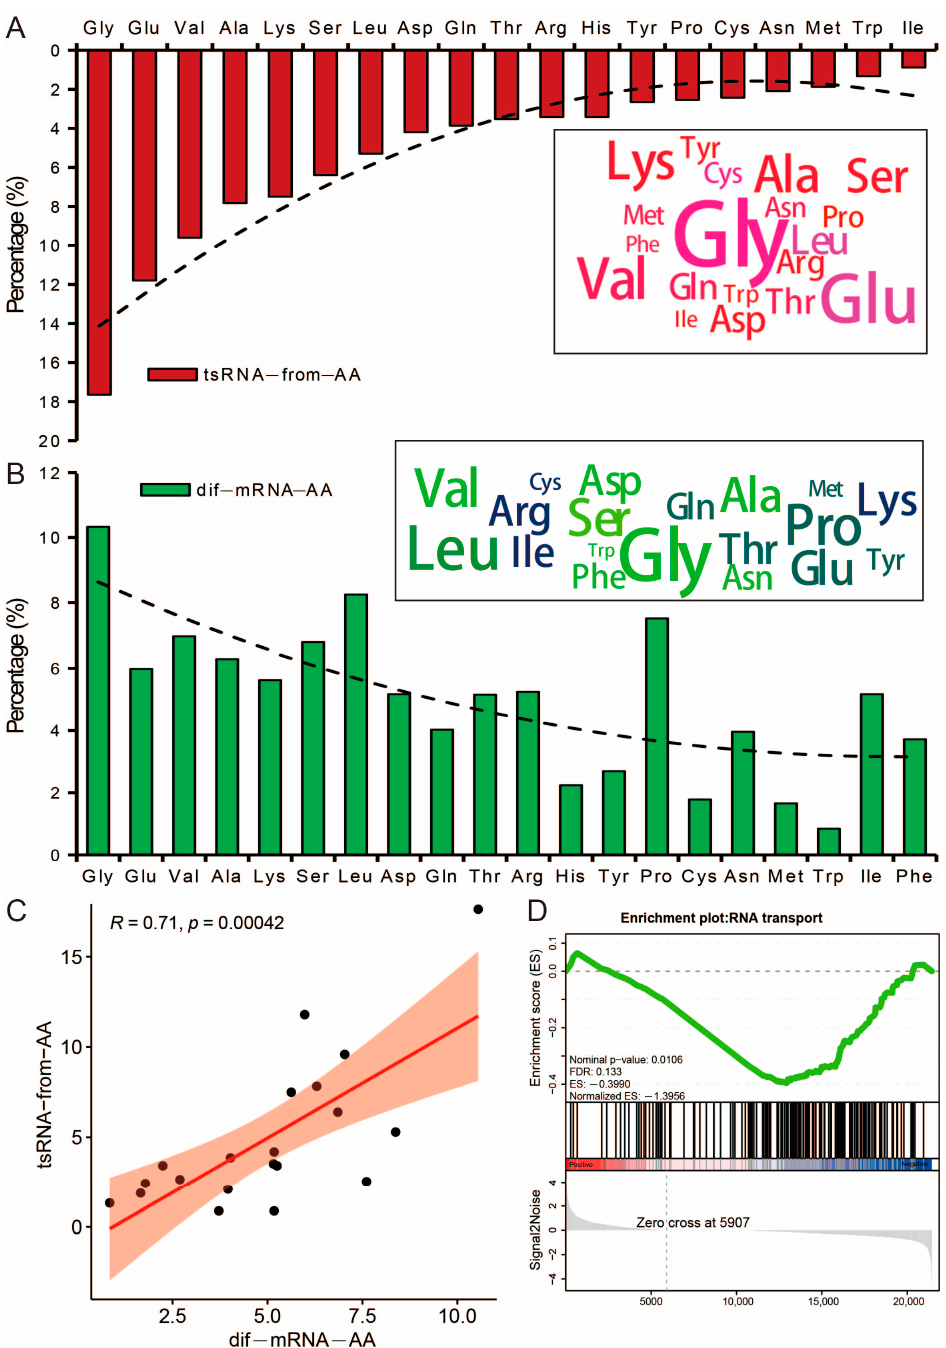
Figure 6. Potential relationship between tsRNA production and host tRNA. ( A ) The portion of tsRNAs based on the classification of transported amino acids. ( B ) Amino acid composition features of the CDS regions of differentially expressed mRNAs. ( C ) Correlation between tsRNA-form-AA and dif-mRNA-AA. ( D ) Results of GSEA of RNA transport.